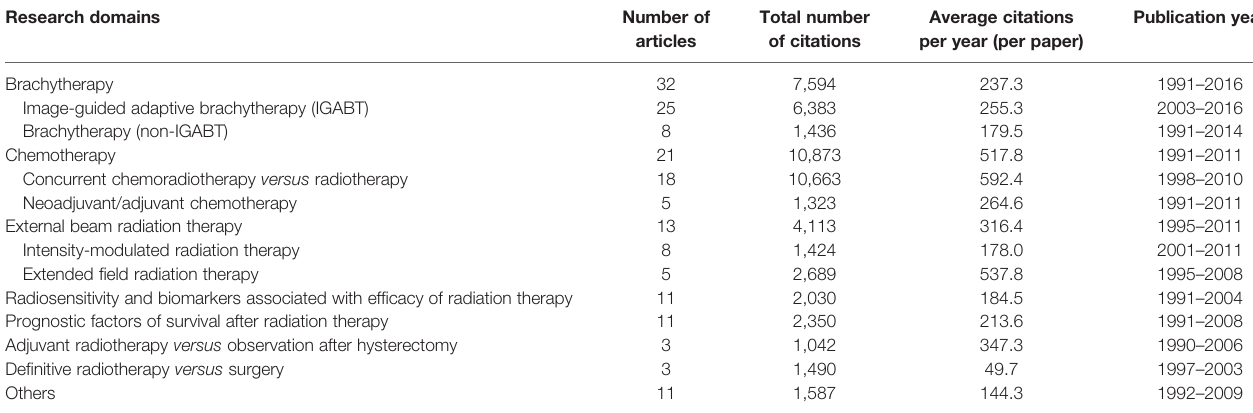
TABLE 2 | Research domains of the 100 most cited papers in radiotherapy or concurrent chemoradiotherapy for cervical cancer between 1990 and 2020.